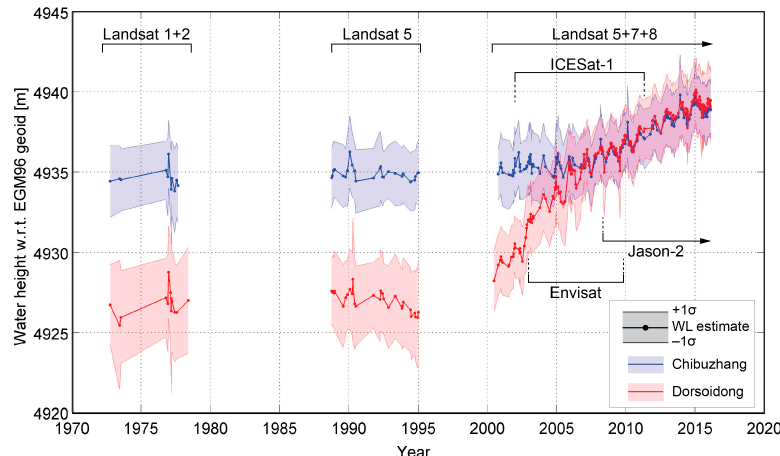
Figure 3. TIAS estimate of lake level in Chibuzhang Co (blue) and Dorsoidong Co (red). Color shades represent the respective time series ±1 σ uncertainty. Temporal coverage of each sensor is annotated where the arrow means ongoing operation of Jason-2 and Landsat-7/-8.